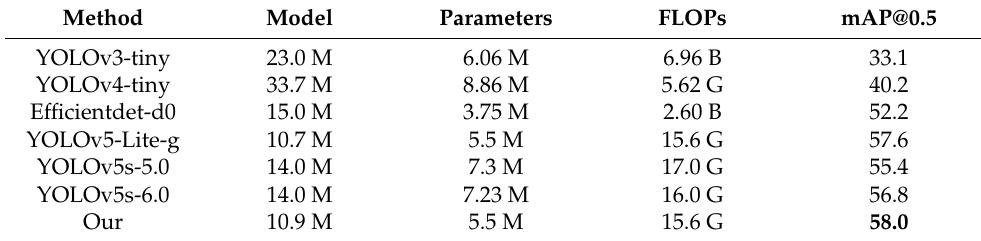
Table 6. Performance comparison on COCO